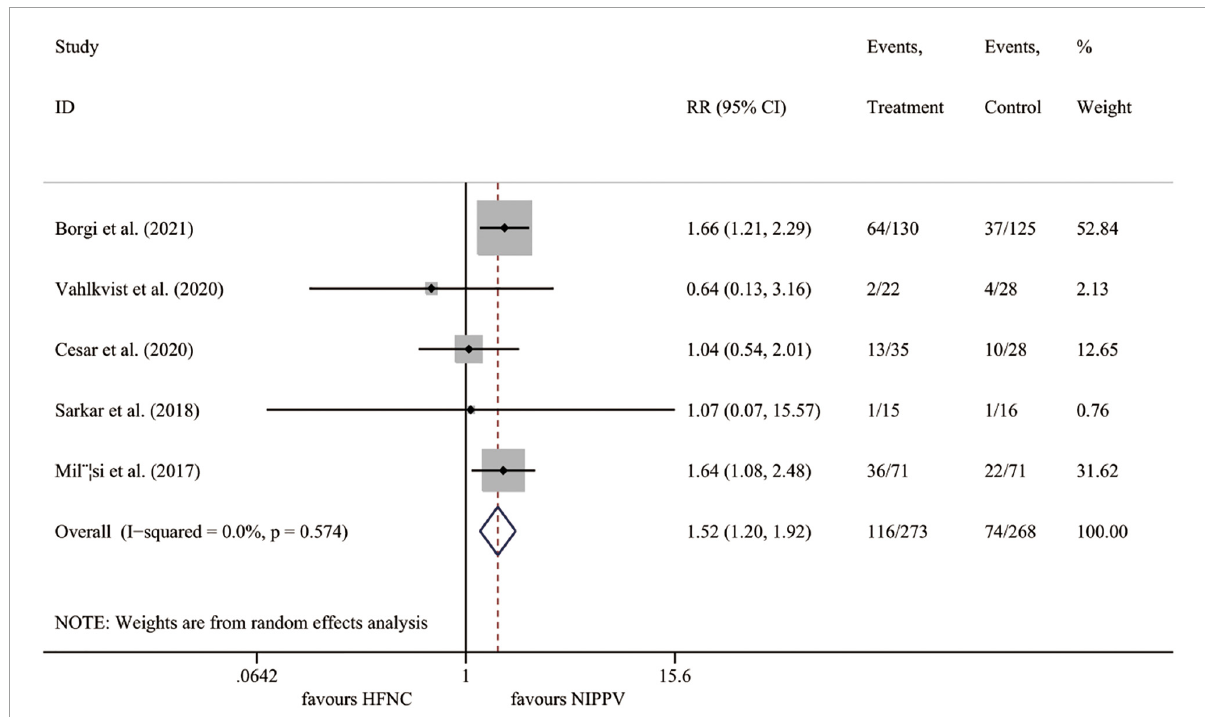
FIGURE3 Forest plot for treatment failure rate. RR, relative risk; HFNC, high flow nasal cannula; NIPPV, non-invasive positive pressure ventilation.